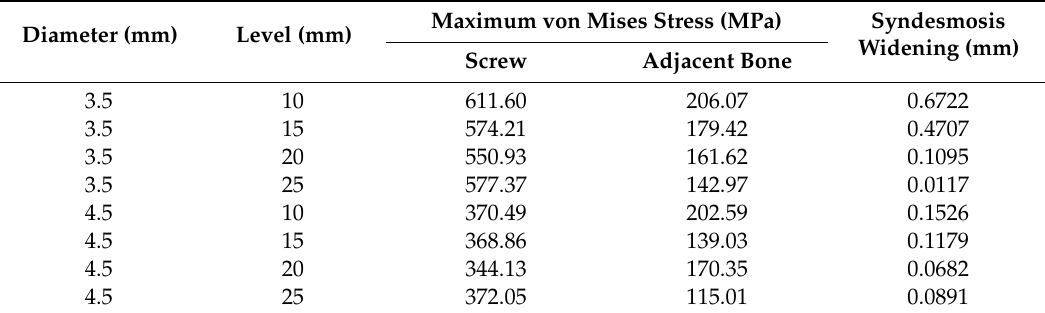
Table 6. Maximum von Mises stresses and syndesmosis widening: titanium with four cortical bones purchased.